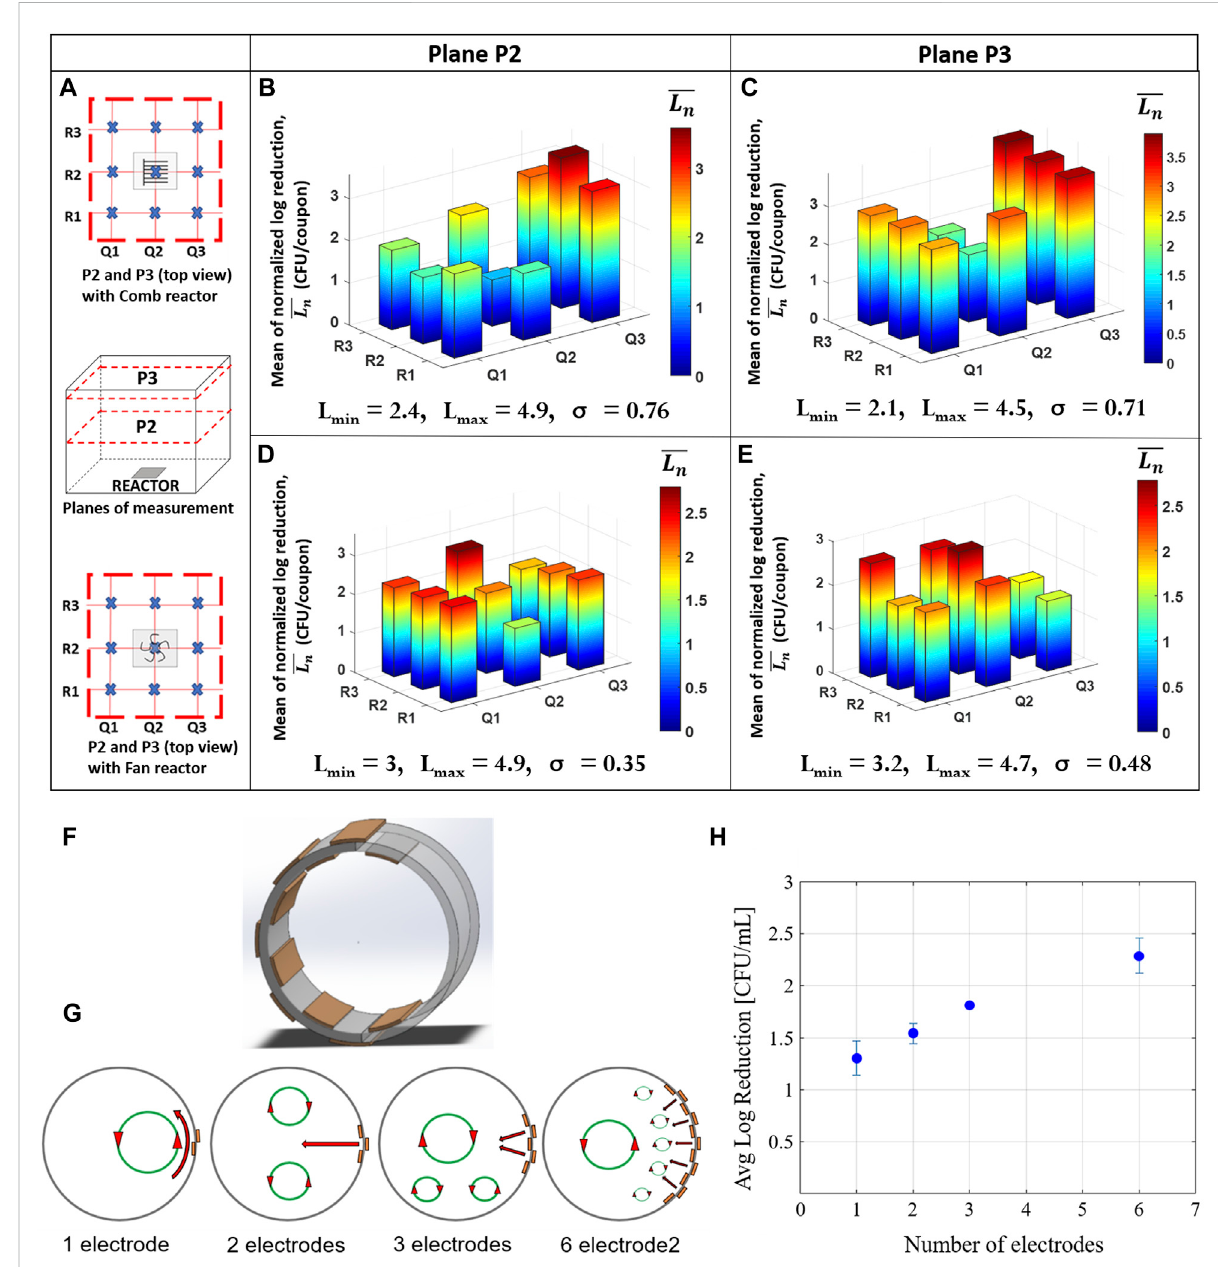
FIGURE 15 Examples of dynamic decontamination introduced in [113, 114]. (A) Measurement planes P2 and P3 with measurement grid and reactor orientation used in the study of SDBD actuated distribution of Escherichia coli decontamination inside a chamber. (B,C) Decontamination distribution using a comb-type reactor at 3.5 min in planes P2 and P3, respectively. (D,E) Decontamination distribution using a fan-type reactor at 3.5 min in planes P2 and P3, respectively. Reactor, respectively. Here, Ln: normalized log reduction; L min and L max : minimum and maximum log reduction achieved in each plane over all the repeats, respectively. σ standard deviation of the mean of normalized log reductions over the plane, indicatinguniformityindecontaminationdistribution[113]. (F) Schematicofexpectedvorticesfromone,two,three,andsixexposedelectrodesinthe cylindrical actuators. (G) Average log reduction (CFU ml − 1 ) of Salmonella cells inoculated onto glass coverslips placed within SDBD actuators with one, two, three, and six electrodes and treated for 4 minutes